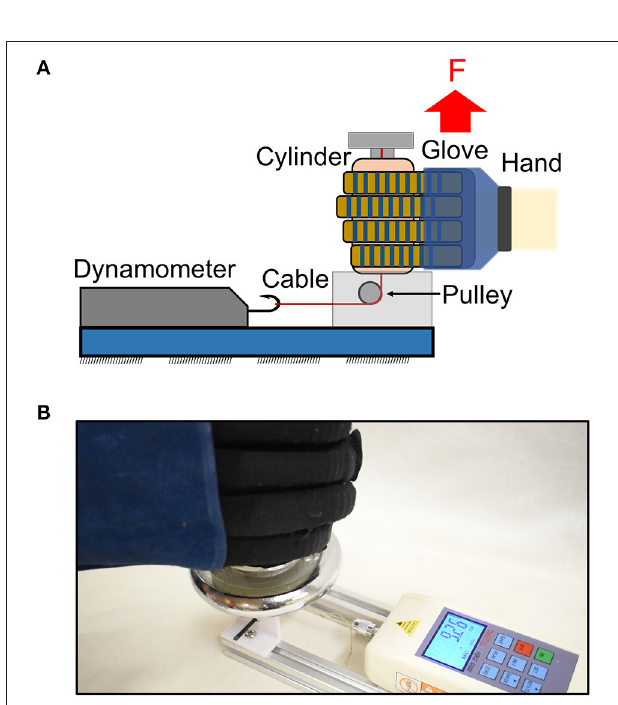
FIGURE 5 | (A) Schematic and (B) the real setup of a portable setup with dynamometer to measure the glove-assisted grip strength. Maximum frictional grip force was recorded before the cylinder released from the actuators’